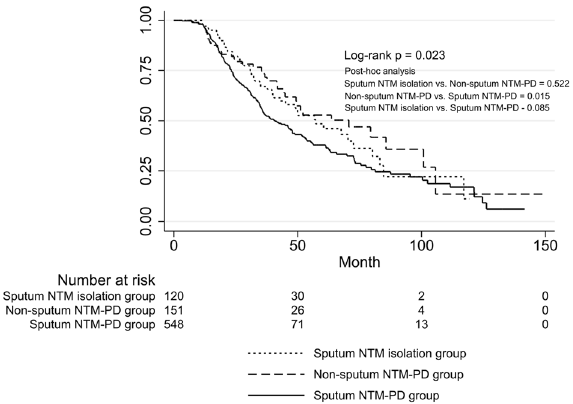
Figure 2. Comparison of time to radiographic aggravation for nontuberculous mycobacterial pulmonary disease (NTM-PD). Radiographic aggravation-free survival was significantly different between the groups (Log rank P = 0.023). Post-hoc analysis on the log-rank test with Bonferroni’s correction showed the significant difference of radiographic aggravation-free survival between the non-sputum and sputum NTM-PD groups. Patients with a single NTM isolation from sputum were designated as the sputum NTM isolation group, patients with positive results from bronchoscopic [e.g., bronchial washing or bronchoalveolar lavage (BAL)] or lung tissue specimens were designated as the NTM-PD group diagnosed using other methods (non-sputum NTM-PD group), and patients with NTM isolation at least two times from separately expectorated sputum samples were designated as the NTM-PD group diagnosed using sputum culture (sputum NTM-PD group).